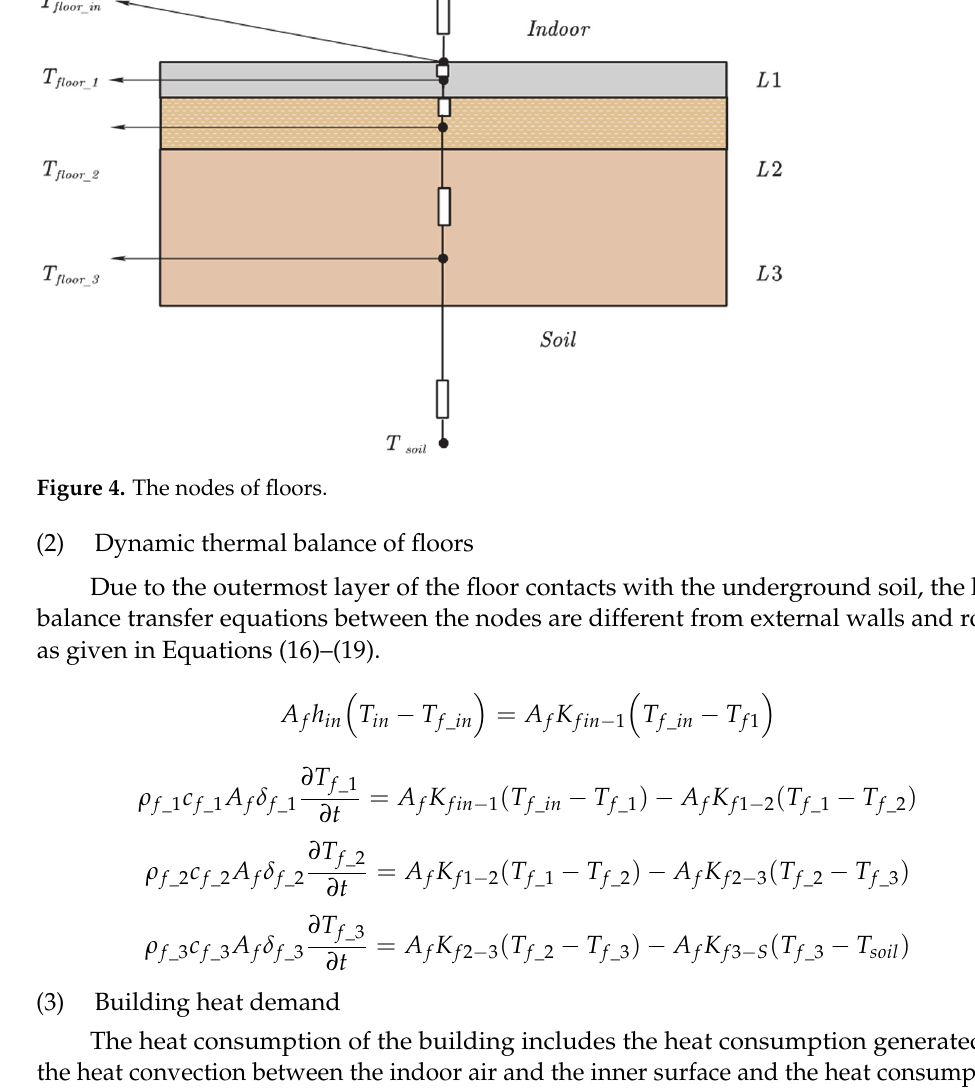
Figure 3. The nodes of roofs.